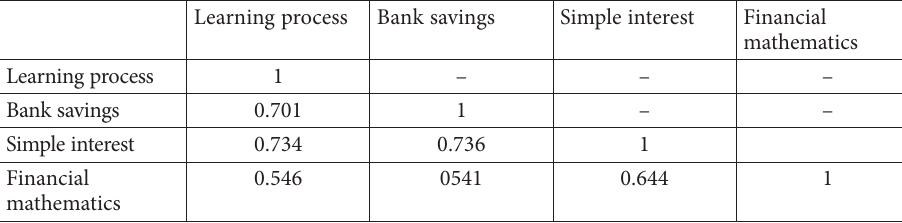
Table 5. Pearson’s correlations (source: created by authors) Learning process Bank